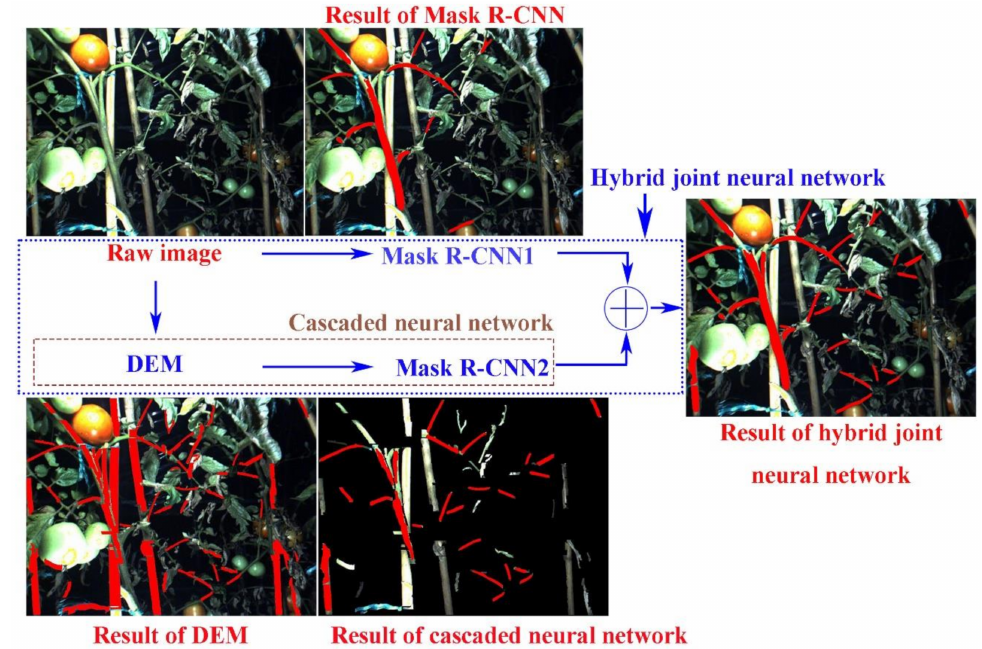
Figure 2. Frame of the hybrid joint neural